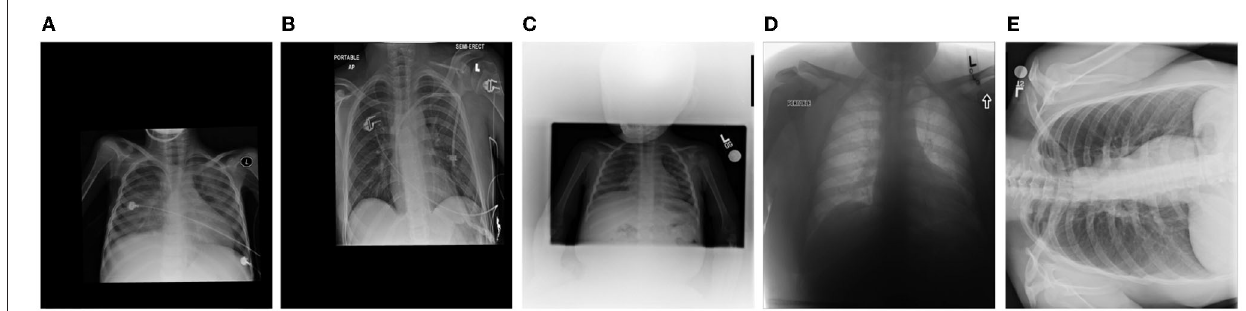
Best results are highlighted in bold.